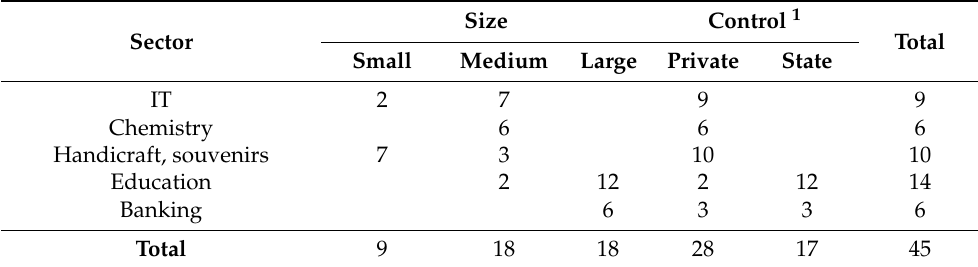
Table 3. Distribution of experts by sectors, according to the companies’ size (number of employees) and ownership (control),